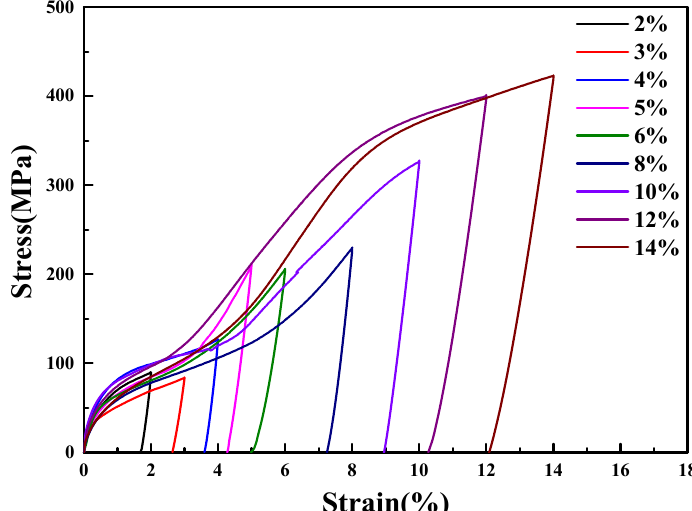
Figure 6. The tensile stress–strain curves of columnar-grained Cu 71.7 Al 18.1 Mn 10.2 alloy samples during cryogenic